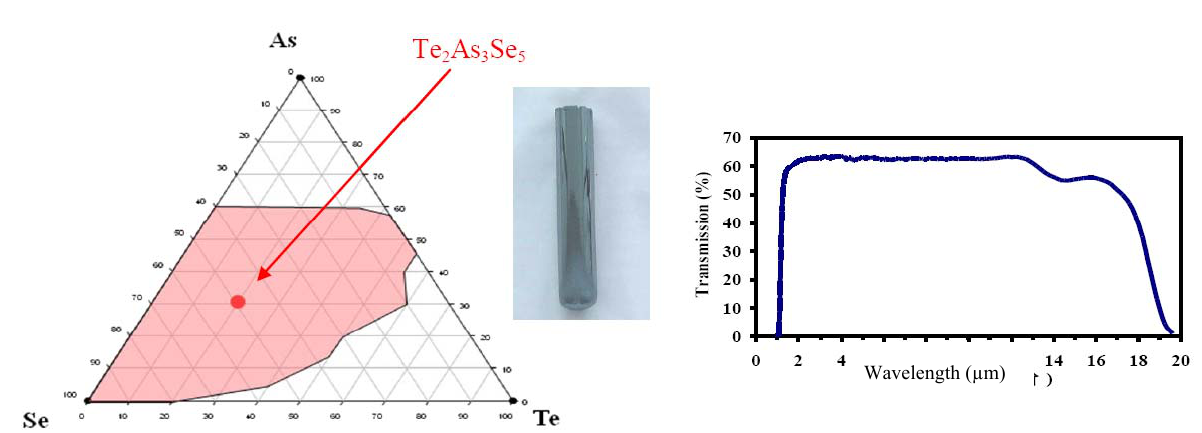
Figure 5. Te/As/Se system including the Te TAS can transmit IR light from 2 to 18 µm and do not exhibit any crystallization peak on DSC curve. This composition is easy to draw into fiber and constitutes an excellent candidate for remote infrared